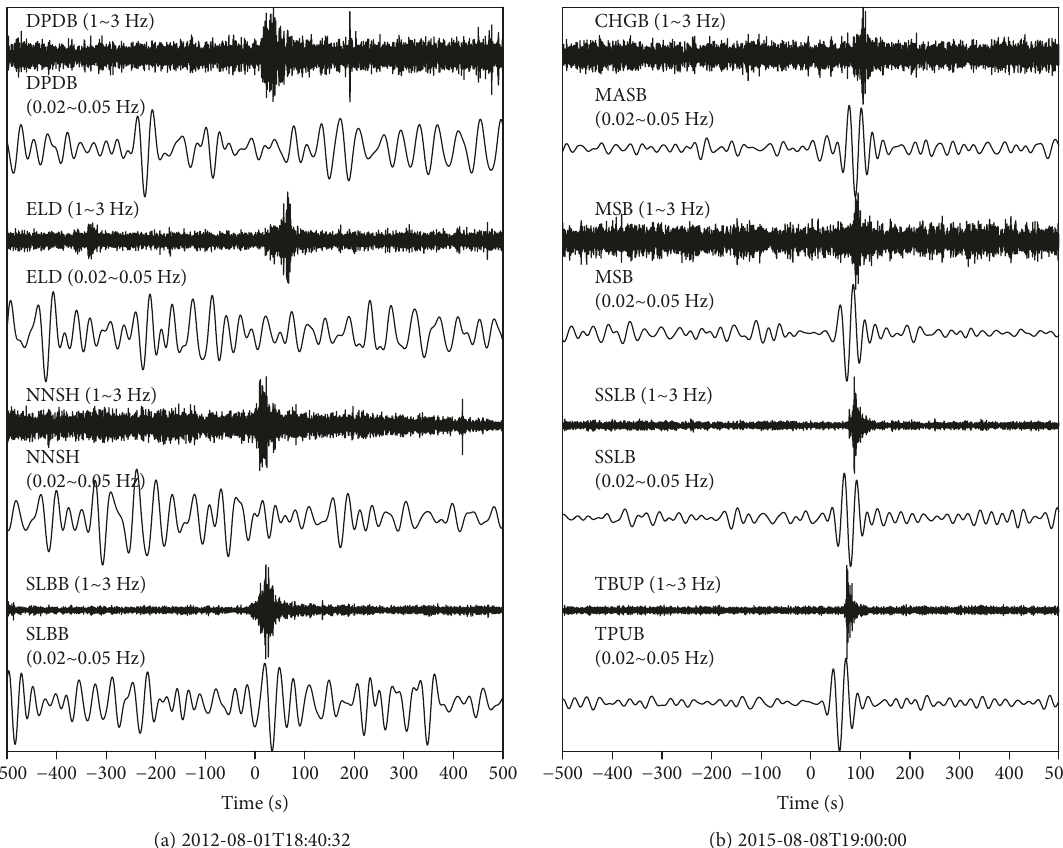
Figure 10: The vertical component broadband seismograms of the landslide events analyzed by our system during the 2012 Typhoon Saola (a) and the 2015 Typhoon Soudelor (b). The seismograms bandpass- fi ltered between 1 and 3 Hz show good SNR for both events, while those fi ltered between 0.02 and 0.05Hz show good SNR for the 2015 event (b) and poor SNR for the 2012 event